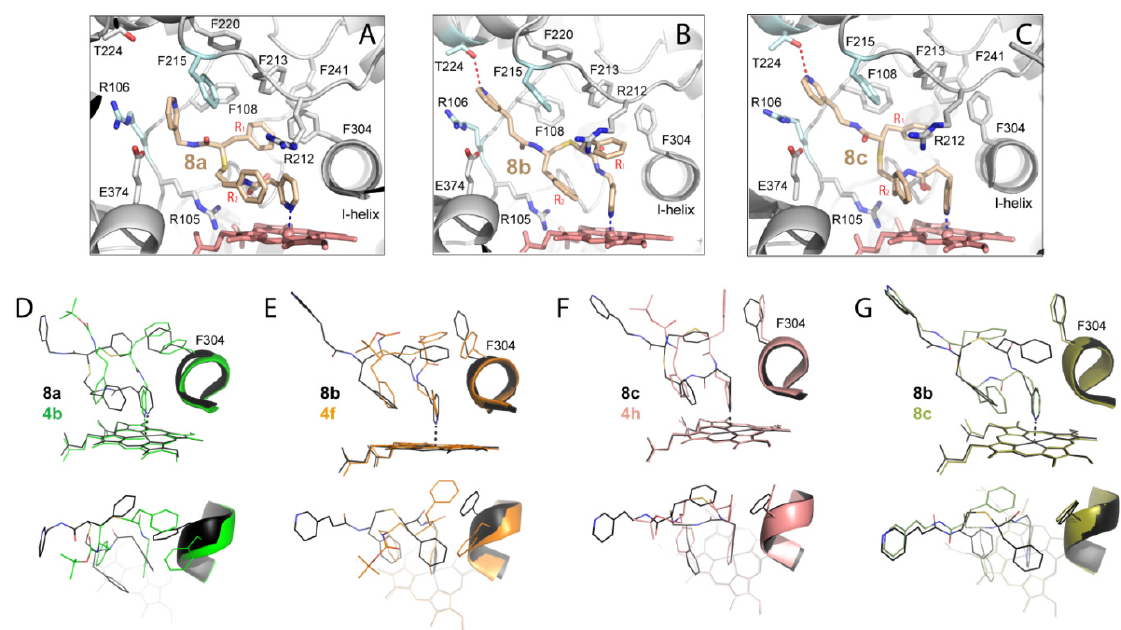
Figure 6. Interactions mediated by 8a – c in the active site of CYP3A4 ( A – C ) and structural comparison of the 8a – 4b ( D ), 8b – 4f ( E ), 8c – 4h ( F ), and 8b – 8c pairs ( G ). ( A – C ) 8a and 8c bind in the reverse orientation, where the end-pyridine ligates to the heme and the head-group stacks in the substrate access channel, while the R 1 and R 2 side-groups (indicated) are still placed at the P1 and P2 sites, respectively. In all three inhibitors, the pyridine group bound in the substrate channel forms π – π and cation– π interactions with Phe215 and the guanidine group of Arg106, respectively. The H-bonds to Thr224 are established only by 8b and 8c (shown as red dotted lines). ( D – G ) The side and top views of structural overlays (upper and lower panels, respectively) highlight positional differences in the backbone and functional groups. The central part of the I-helix is depicted to demonstrate the adaptive rotameric changes in Phe304. The 4b -, 4f -, and 4h -bound CYP3A4 structures used for comparison have the PDB ID codes 6DA3, 6DAC, and 6DAG, respectively.